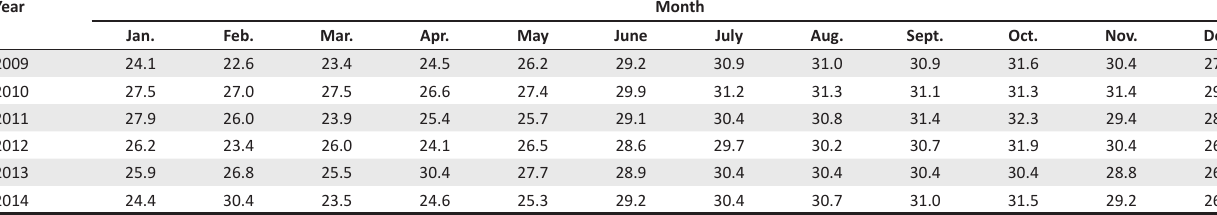
TABLE 1: Monthly means of maximum temperatures (°C). Year